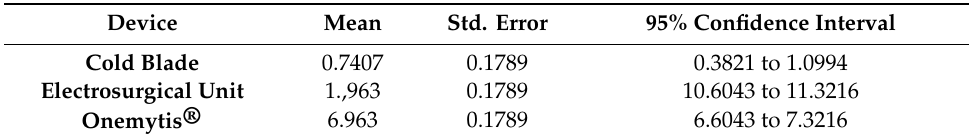
Table 2. Dermal Score.